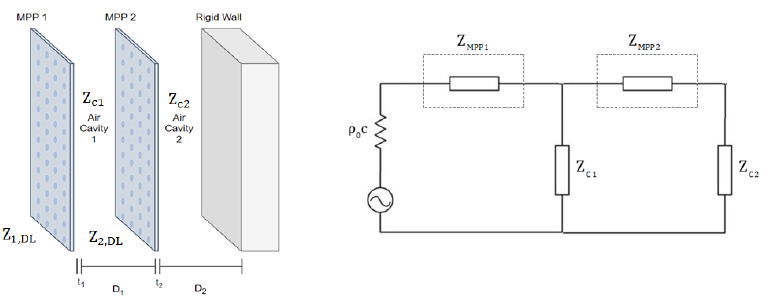
Figure 3. Double-layer (DL)-MPP schematic representation ( left ) and the corresponding equivalent electrical system ( right